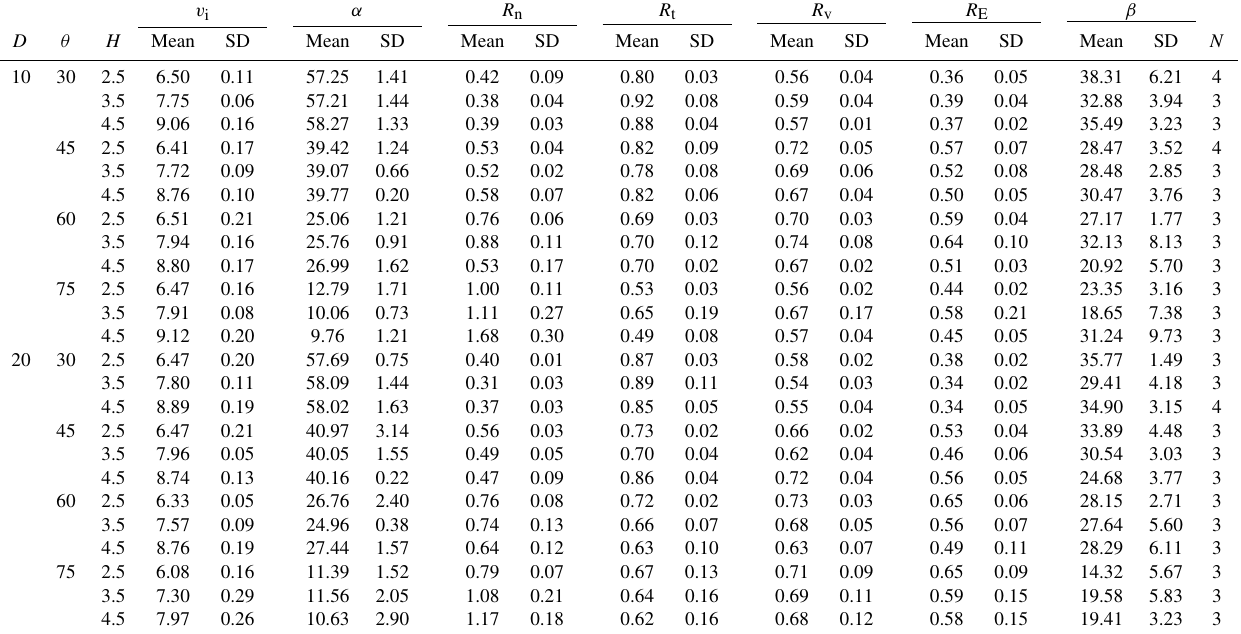
Table 1. Release conditions and results of our experiments. D – the diameter of samples (cm); θ – the inclined angle of the landing plate ( ◦ ); H – the release height (m); v i – the impact velocity (ms − 1 ); α – the impact angle ( ◦ ); R n – the normal coefficient of restitution; R t – the tangential coefficient of restitution; R v – the kinematic coefficient of restitution; R E – the kinetic energy coefficient of restitution; β – the rebound angles ( ◦ ). N denotes the test numbers for one release